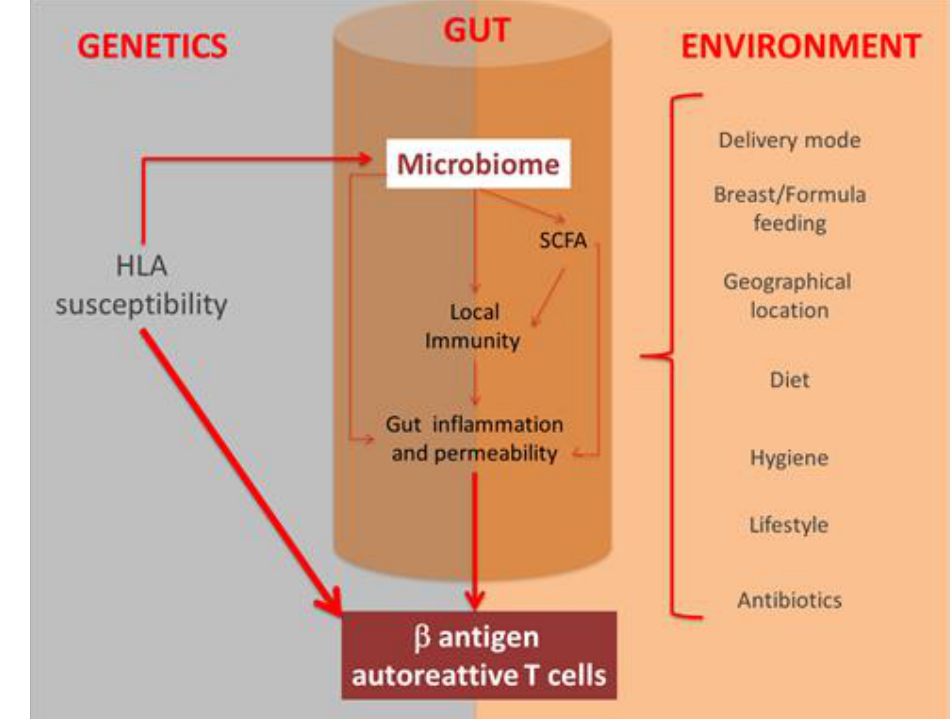
Figure 1. Interplay between genetics, environment, and gut microbiota in T1DM pathogenesis. Specific HLA allele can increase susceptibility to the development of type 1 diabetes and influence the composition of the gut microbiota. Many environmental factors can also shape the gut microbiota. Abnormalities in the gut microbiome are believed to favor autoimmunity against pancreatic b-cells by modulating the gut immune/inflammatory response and by enhancing the gut barrier permeability both directly and indirectly through reduced production of short-chain fatty acids (SCFAs).